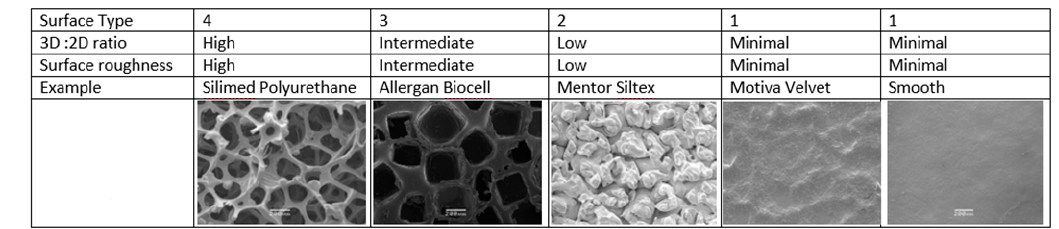
Figure 1. Implant surface classification and representative examples of implants.